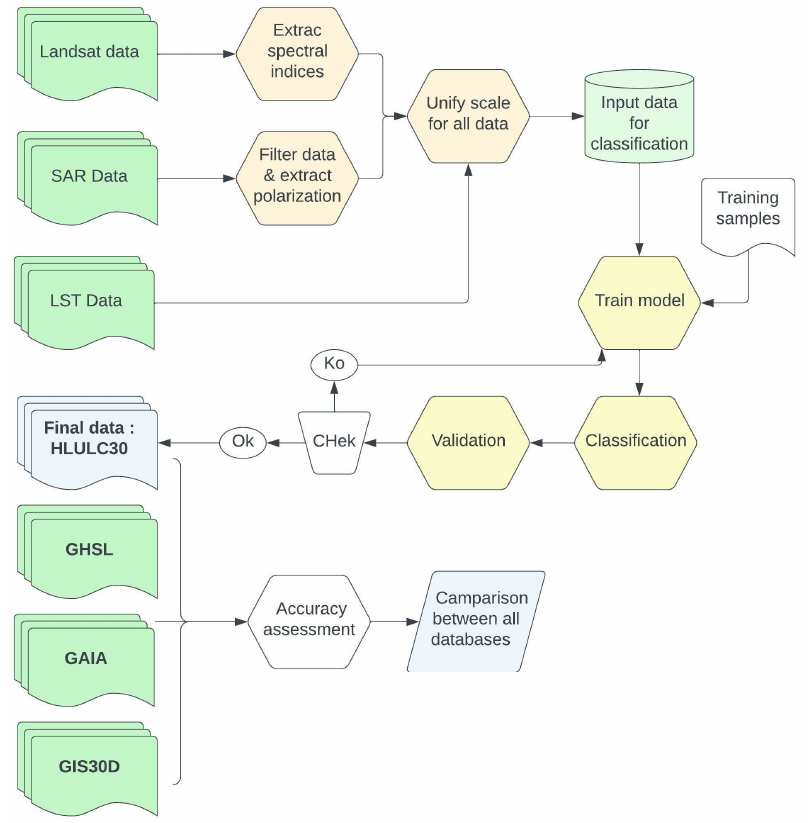
Figure 1. Flowchart of the study.